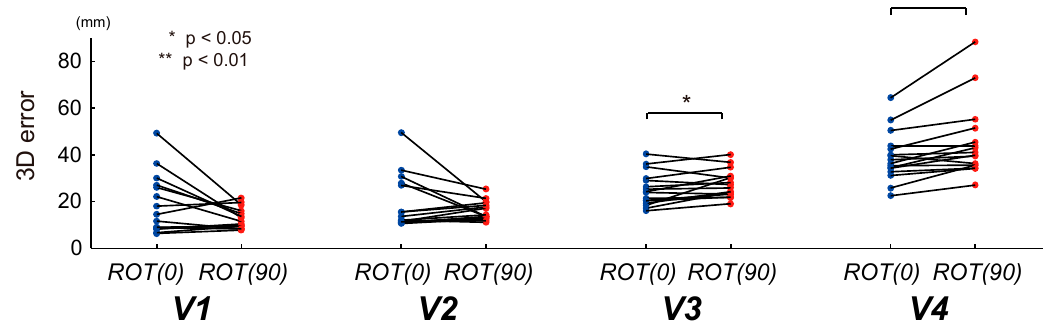
Figure 6. Evaluation of the circular tracking performance based on Δ 3D (3D error; spatial errors in Cartesian coordinates) . Note that, there was a statistically significant Δ 3D difference under V3 and V4 conditions between ROT (0) and ROT (90).